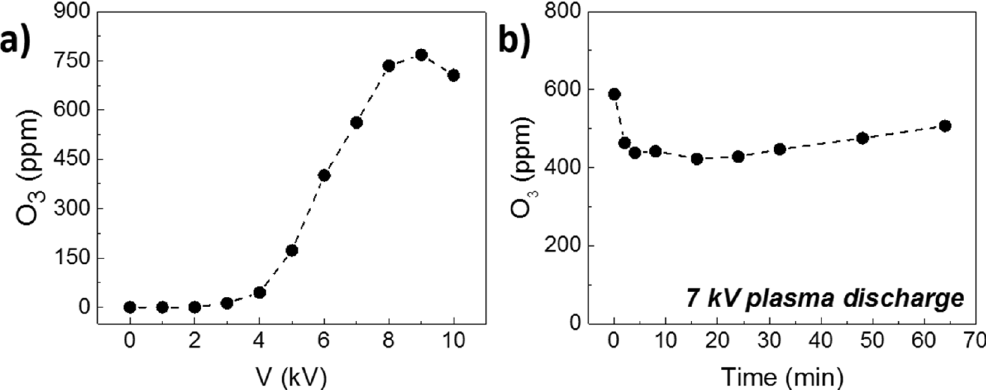
Figure 5. ( a ) Ozone concentration as a function of DBD plasma dishcarge voltage. ( b ) Ozone concentration as a function of time (maximum disinfection time) for 7 kV applied voltage.